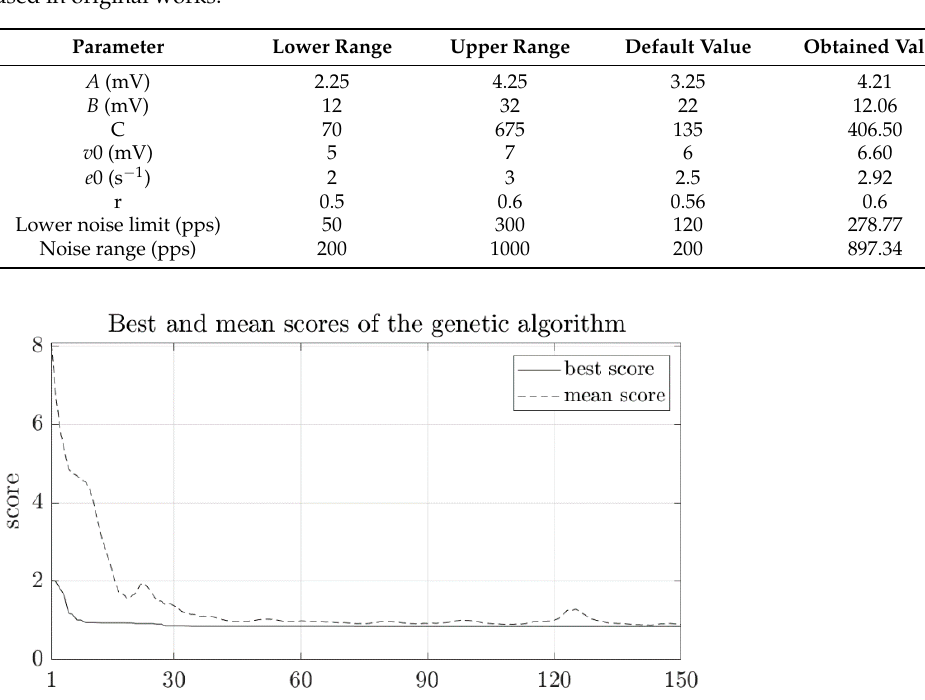
Table 4. Values of parameters obtained for the measured signal. Values in column “default” were used in original works.